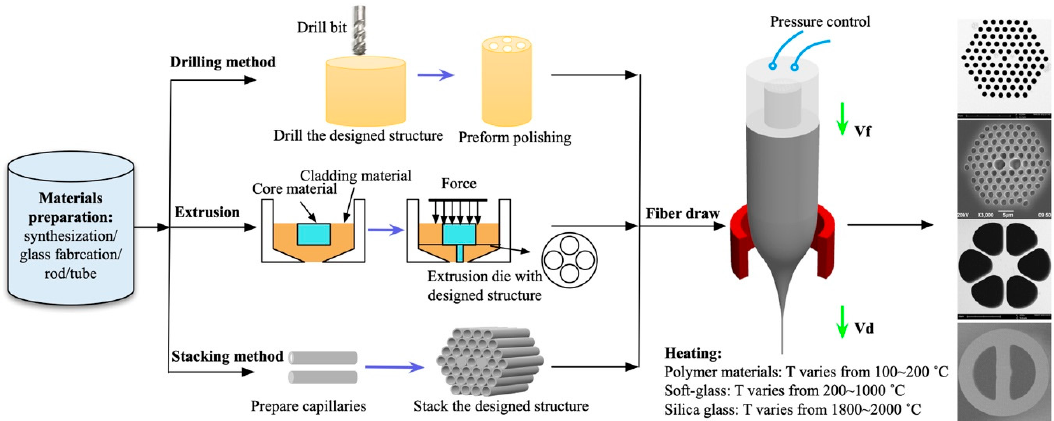
Figure 2. Schematic of MOF fabrication using drilling, extrusion, and stacking methods.